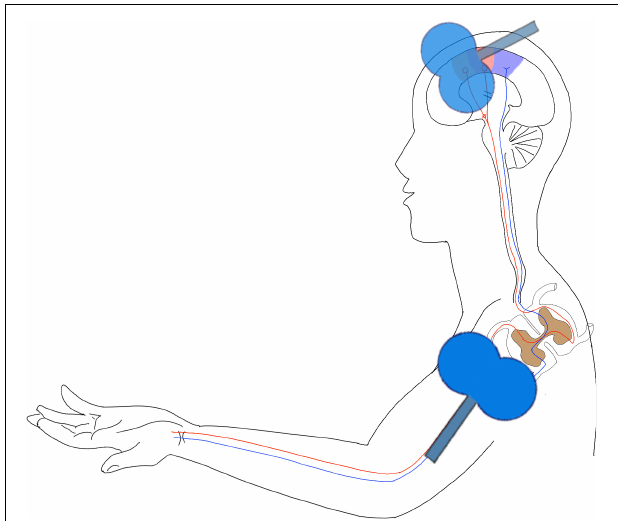
FIGURE 1 | Hebbian-type stimulation (HTS). This figure is a schema chart of the intervention model of the study. In the figure, the purple area on the head is the primary sensory area, the red area is the primary motor cortex, and the position of the coil is the SMA area. In this study, the joint stimulation of the central and peripheral was used to reconstruct the pathway from the SMA area to the peripheral